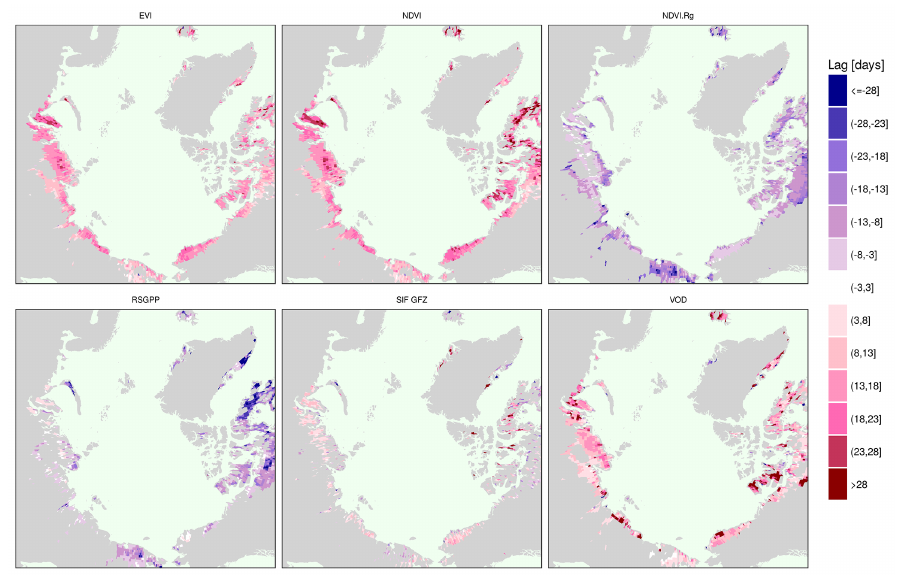
Figure A7. Average time difference of the yearly maximum across years between selected vegetation proxies and the air temperature based on 50 bootstrap samples of the time series. Shown are only statistically significant differences at a level of 5%.